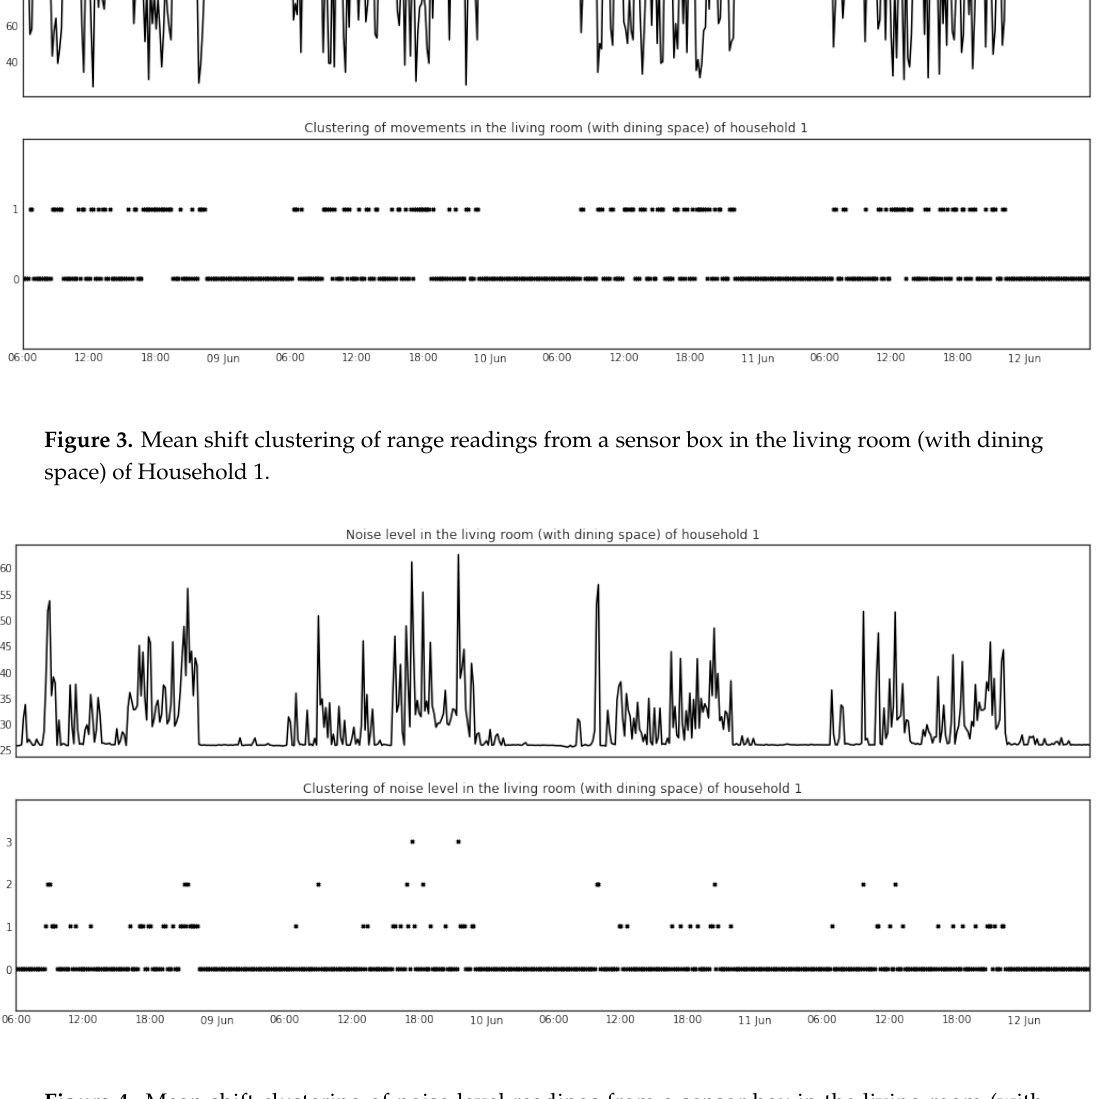
Figure 4. Mean shift clustering of noise-level readings from a sensor box in the living room (with dining space) of Household